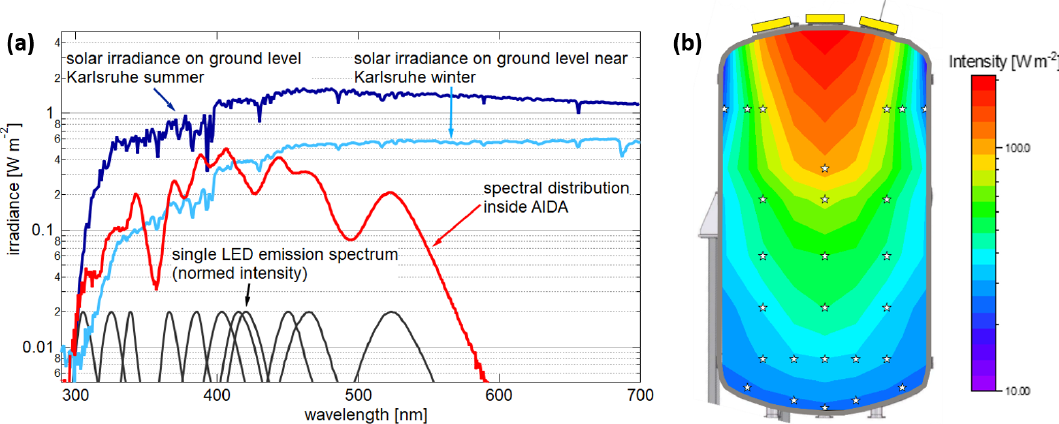
Figure 2. (a) Light spectrum inside the AIDA chamber, measured at a central position at a height of 2.9m above the chamber floor. Solar irradiance for winter was measured with a calibrated spectrometer at KIT. The solar irradiance for summer is calculated with the NCAR UCAR Quick TUV model (further information in the Supplement). The ratios of the mean intensity inside the AIDA chamber and the maximum values outside are given in Fig. S3 for summer and winter. (b) Light intensity distribution interpolated based on measurements at 26 different positions (white stars) inside the AIDA chamber.